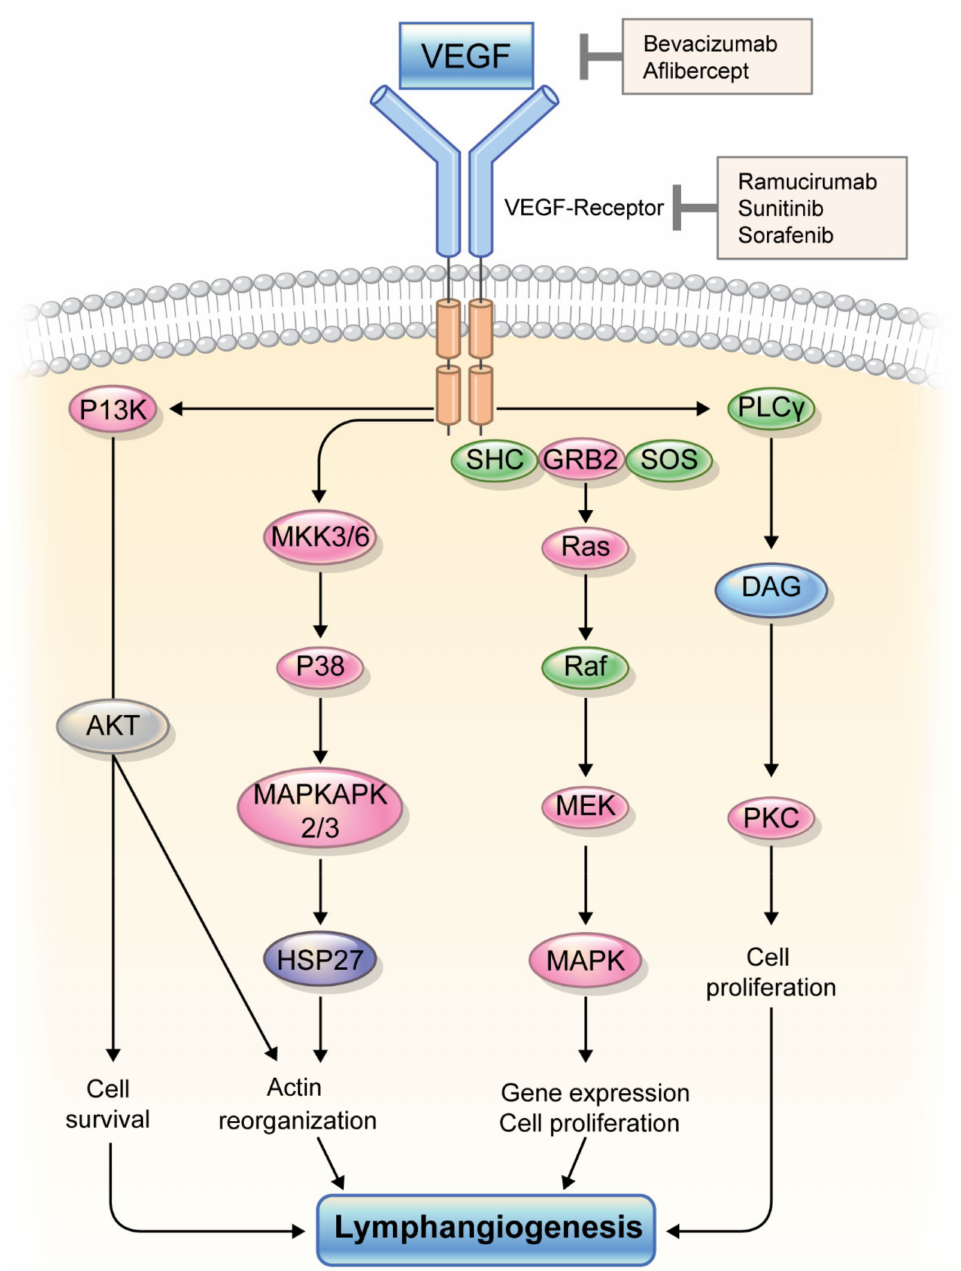
Figure 2. Intracellular signaling pathway of VEGF and VEGF receptor for lymphangiogenesis. VEGF, vascular endothelial growth